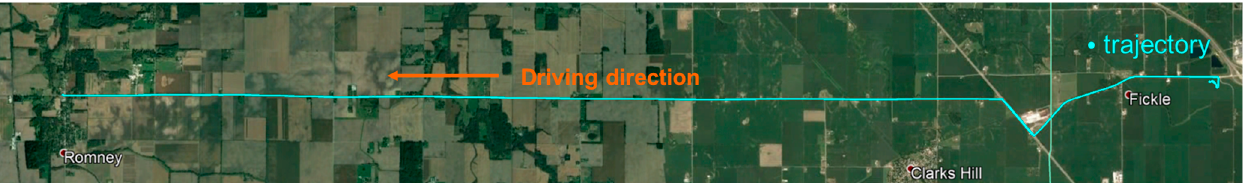
Figure 6. RGB images for new lane marking patterns in the target domain dataset: ( a ) one-lane highways with dual lane marking at the center, ( b ) dual lane markings at the edge, and ( c ) pair of dual lane markings at the edge.